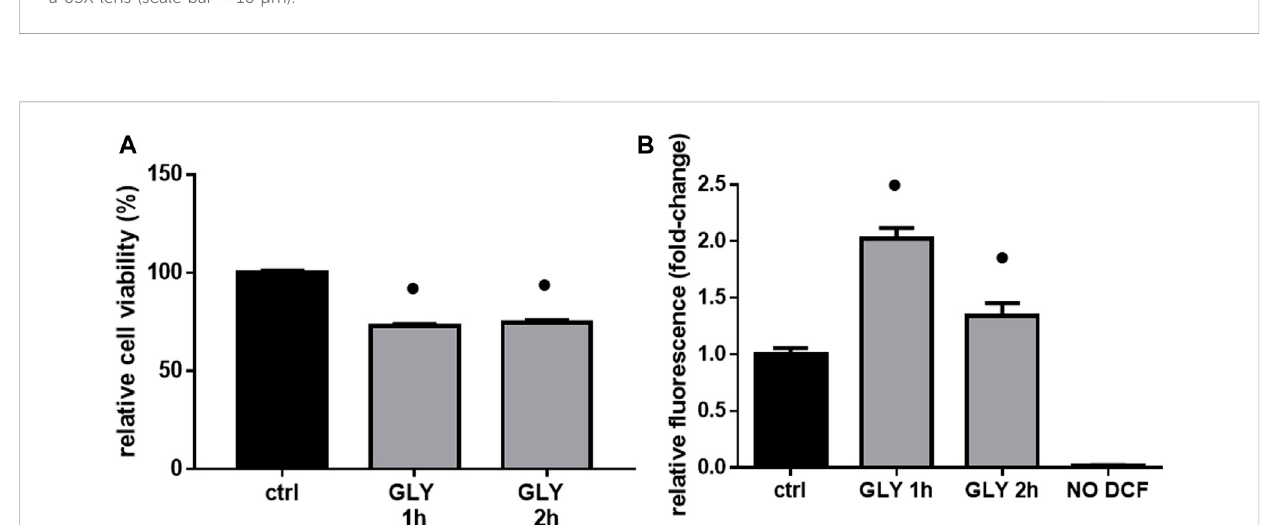
FIGURE 3 Cell viability & ROS production. The fi gure shows the relative histograms obtained from: (A) MTT and (B) DCF-DA assays. H9c2 cells were treated with10 mMofglyphosate(GLY)for1or2